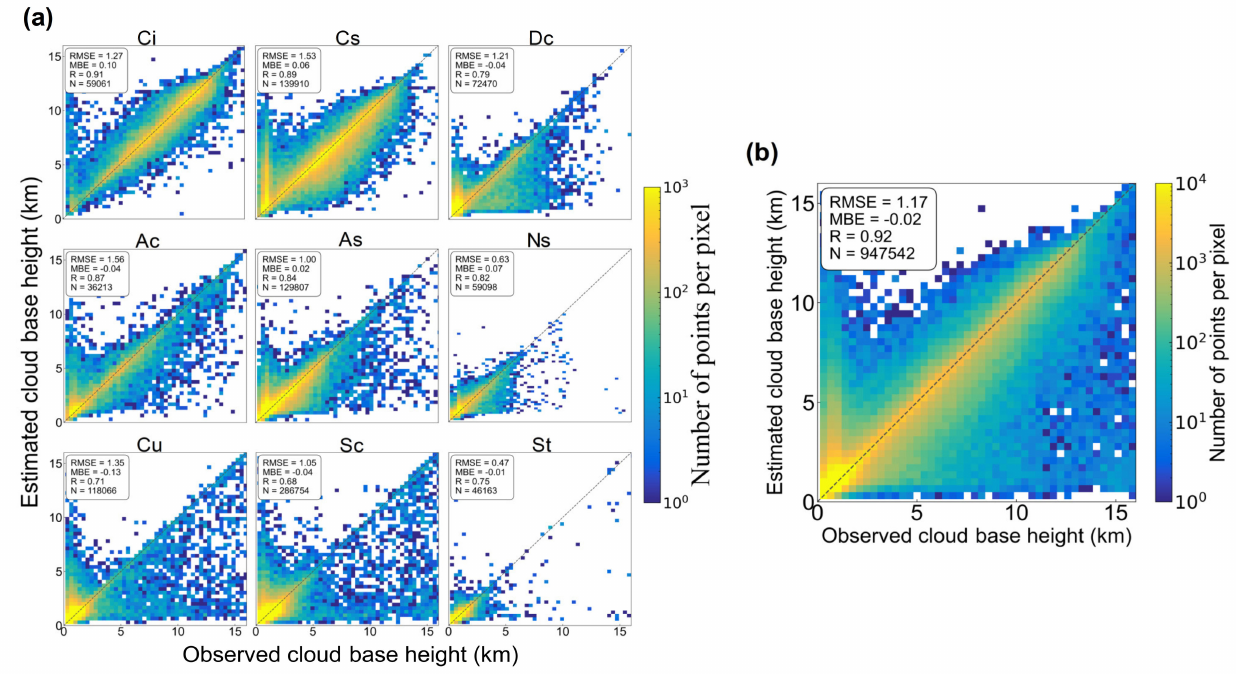
Figure 6. RF-CBH performance: ( a ) the performance of RF-CBH for different cloud types. Ci: cir- rus, Cs: cirrostratus, Dc: deep convection, Ac: altocumulus, As: altostratus, Ns: nimbostratus, Cu: cumulus, Sc: stratocumulus, St: stratus; ( b ) the performance of RF-CBH for all cloud